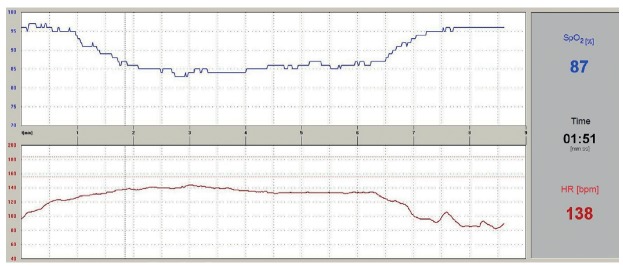
Monitoring of HR and SpO2.